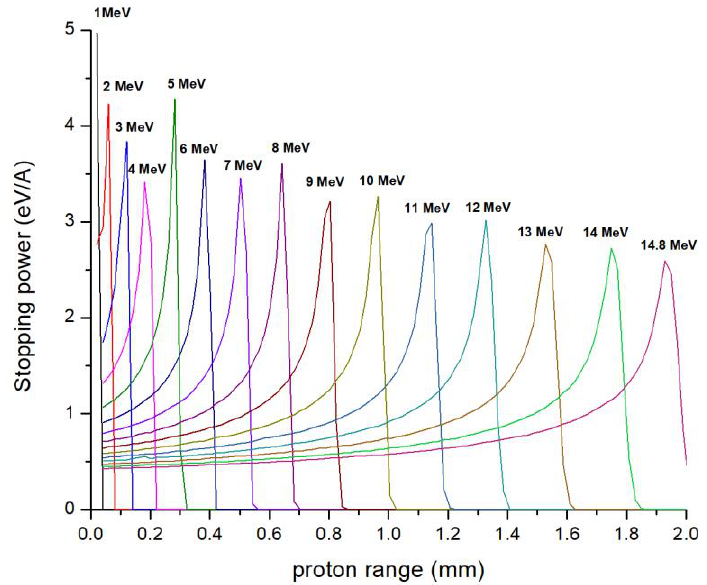
Figure 5. Bragg peak positions in CR-39 detector stack. Table 1. Data obtained from SRIM simulation of the detector stack.